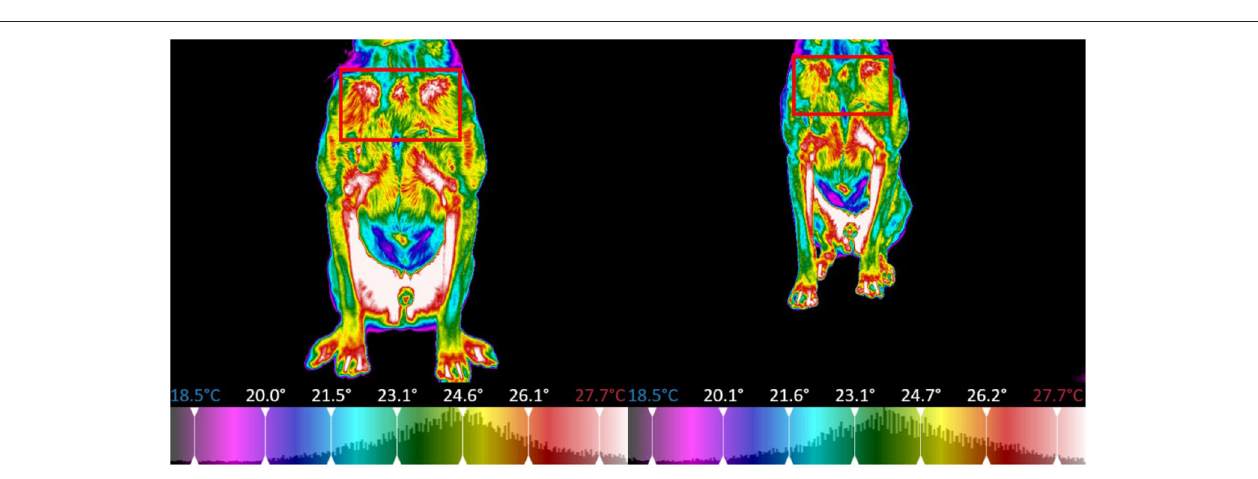
FIGURE 11 | Sectioned muscle regions ventral view (Left, pre-exercise; Right,